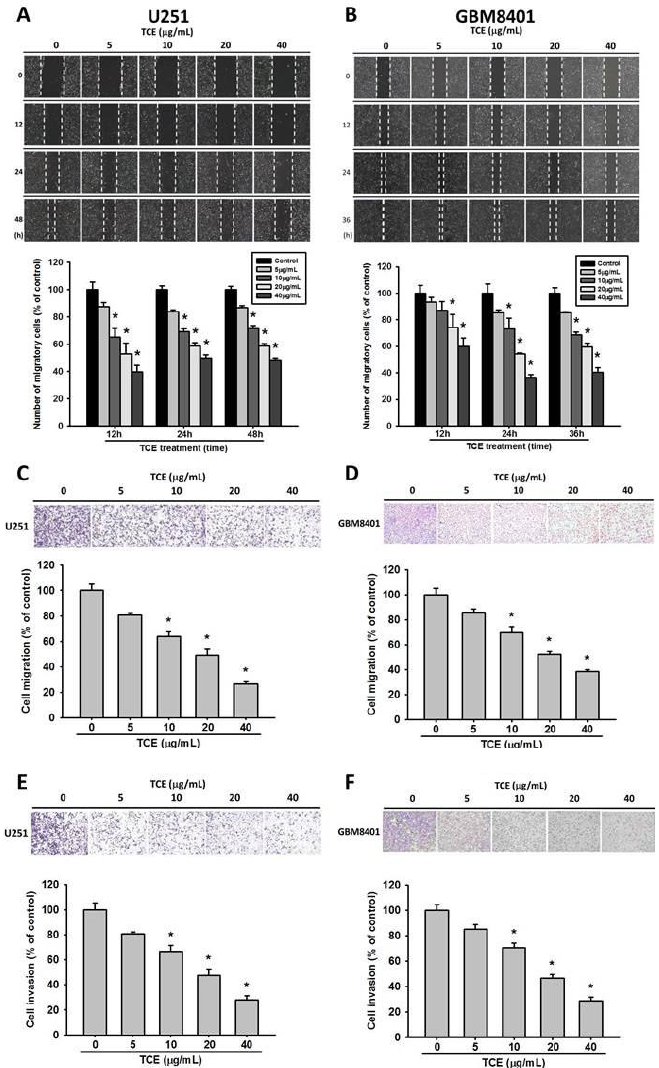
Figure 2. Effects of T. catappa L. extract (TCE) on migration and invasion of U251 and GBM8401 cells. The motility of U251 ( A ) and GBM8401 ( B ) cells were assessed by in vitro wound closure assay with different concentrations of TCE (0, 5, 10, 20 and 40 μg/mL) at 12, 24 and 48 h. Cell migration ( C , D ) and invasion ( E , F ) were measured using a Boyden chamber for 24 h with polycarbonate filters. * p < 0.05, compared with the vehicle group.